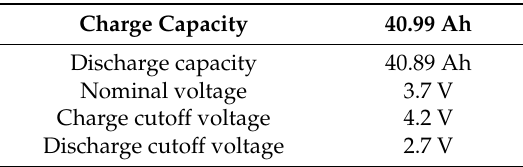
Table 1. Specification of the tested